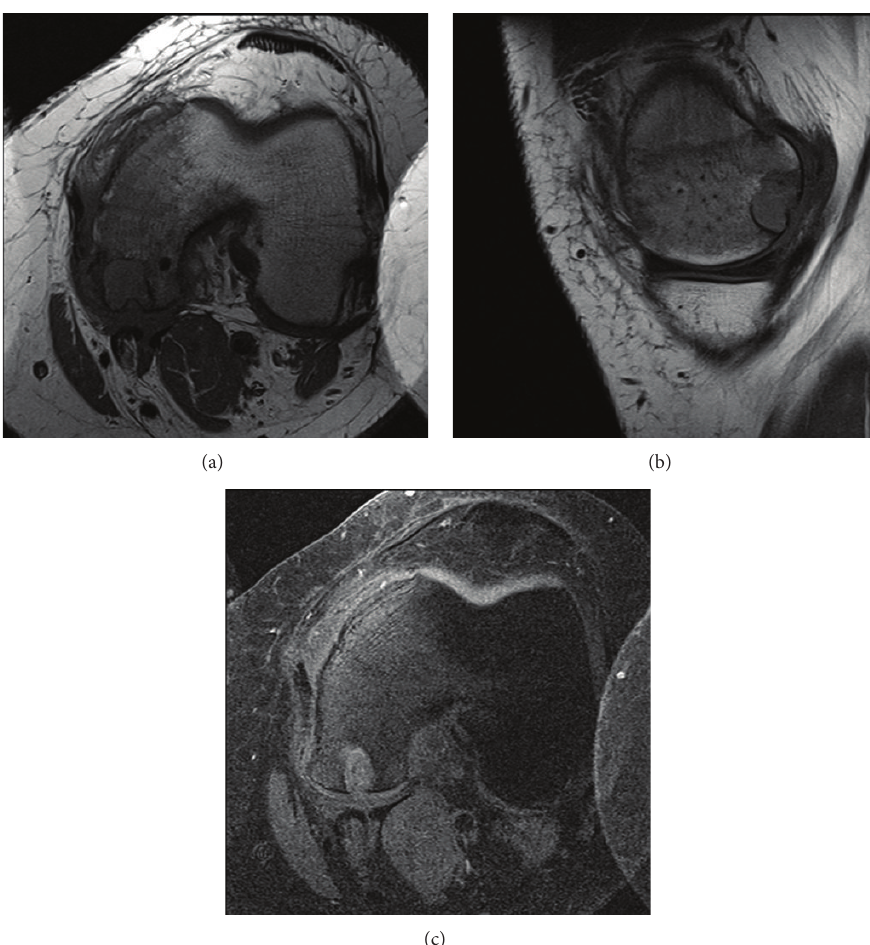
Figure 3: T1 TSE axial (a) and sagittal (b) images and T1 TSE w/FS axial (c) image showing a lytic lesion with sclerotic borders involving the posterior aspect of the medial femoral condyle and abutting the posterior articular surface with 3mm collapse of the subchondral bone and breach of the chondral